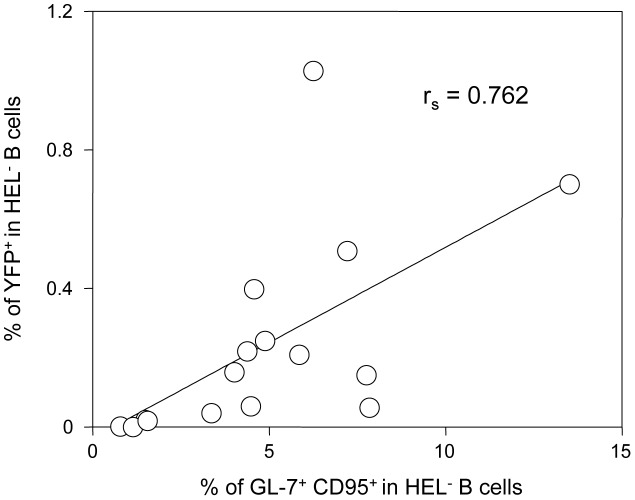
The frequency of infection correlates with the magnitude of the germinal center response in HEL− B cells.To study the interrelationship between the GC response and the frequency of YFP+ cells, matched data obtained from SWHEL mice 14 dpi (n = 16) were plotted against each other. For each SWHEL mouse, the Y-axis shows the frequency of YFP+ cells in HEL− B cells (data from Figure 2A) and the X-axis shows the frequency of GC (data from Figure 6B). Rs was calculated using Spearman's rank correlation coefficient.